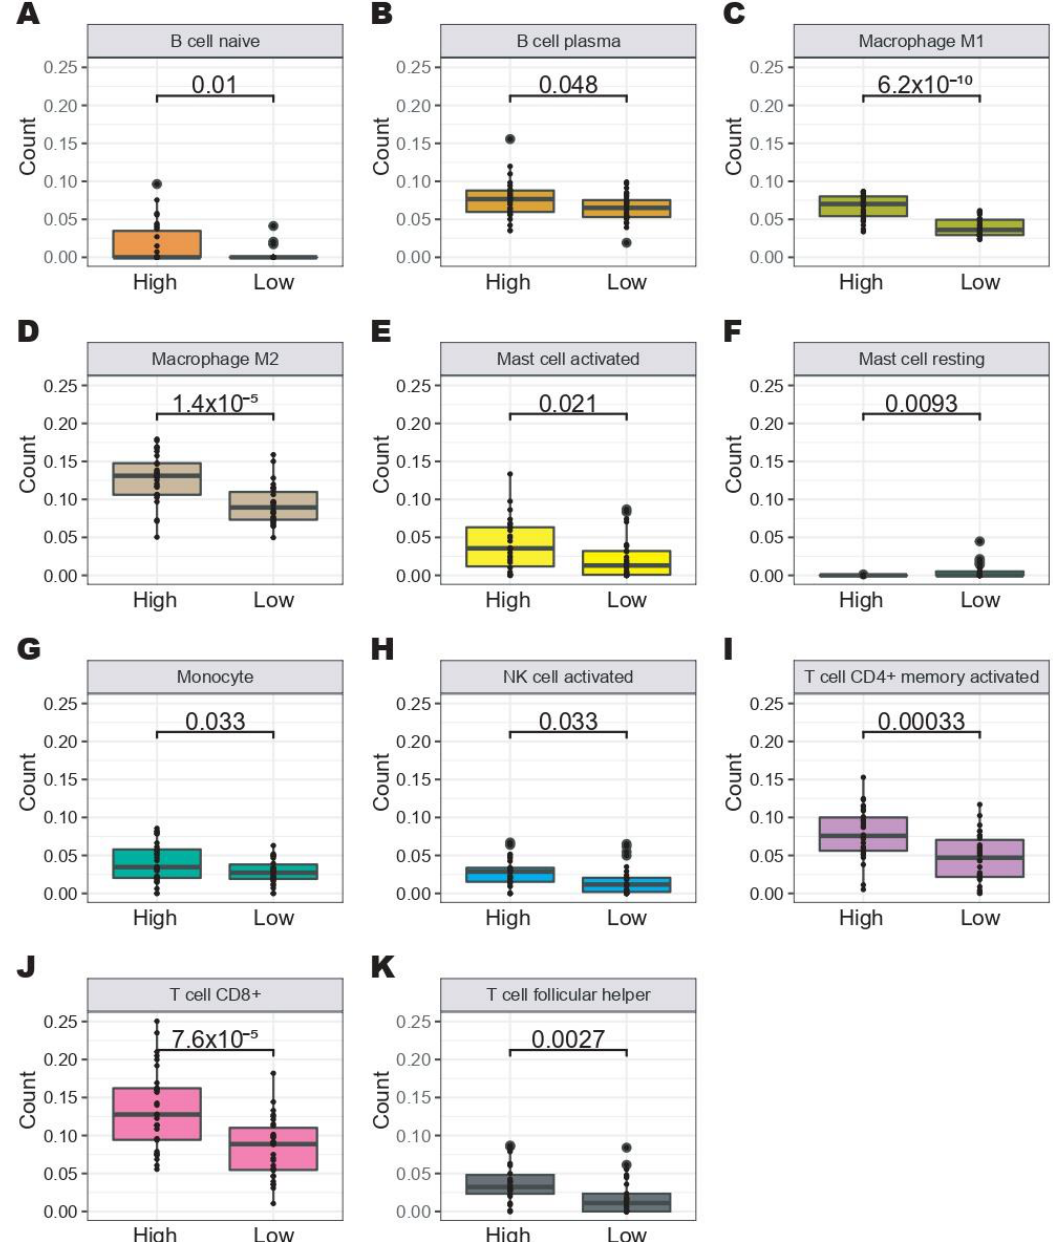
Figure 7. High FLI-1 expression is associated with significant immune cell recruitment in cervical cancer. Quantification of ( A ) B cell naive, ( B ) B cell plasma, ( C ) macrophage M1, ( D ) macrophage M2, ( E ) mast cell activated, ( F ) mast cell resting, ( G ) monocyte, ( H ) NK cell activated, ( I ) T cell CD4+ memory activated, ( J ) T cell CD8+, and ( K ) T cell follicular helper in CC patients with high FLI-1 expression and low FLI-1 expression from the TCGA dataset using CIBERSORTx software. The data used were transformed to log2, which allows the use of the Student t -test.